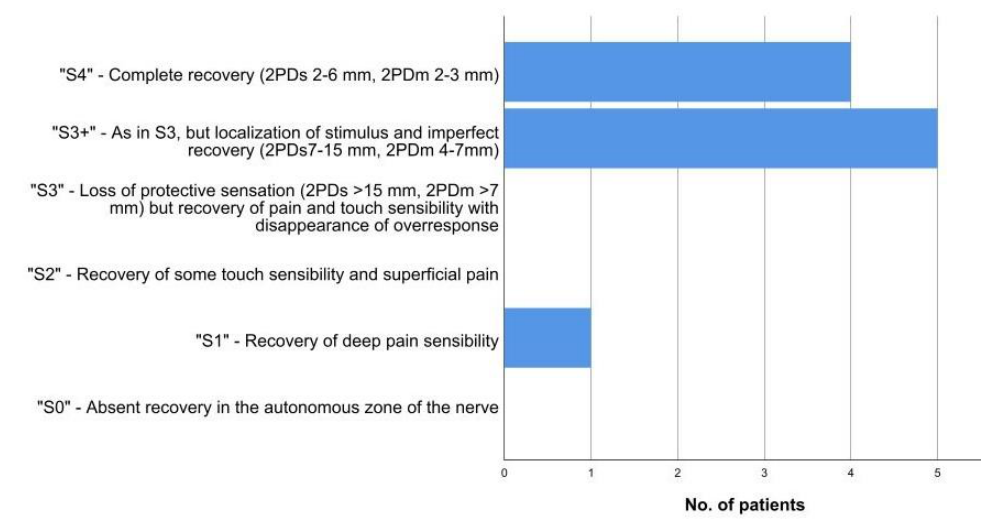
Figure 2. Stratification of sensory recovery by Highet and Sander’s criteria modified by Mackinnon and Dellon [21]. All but one patient regained measurable static and moving two-point discrimination (2PDs, 2PDm).